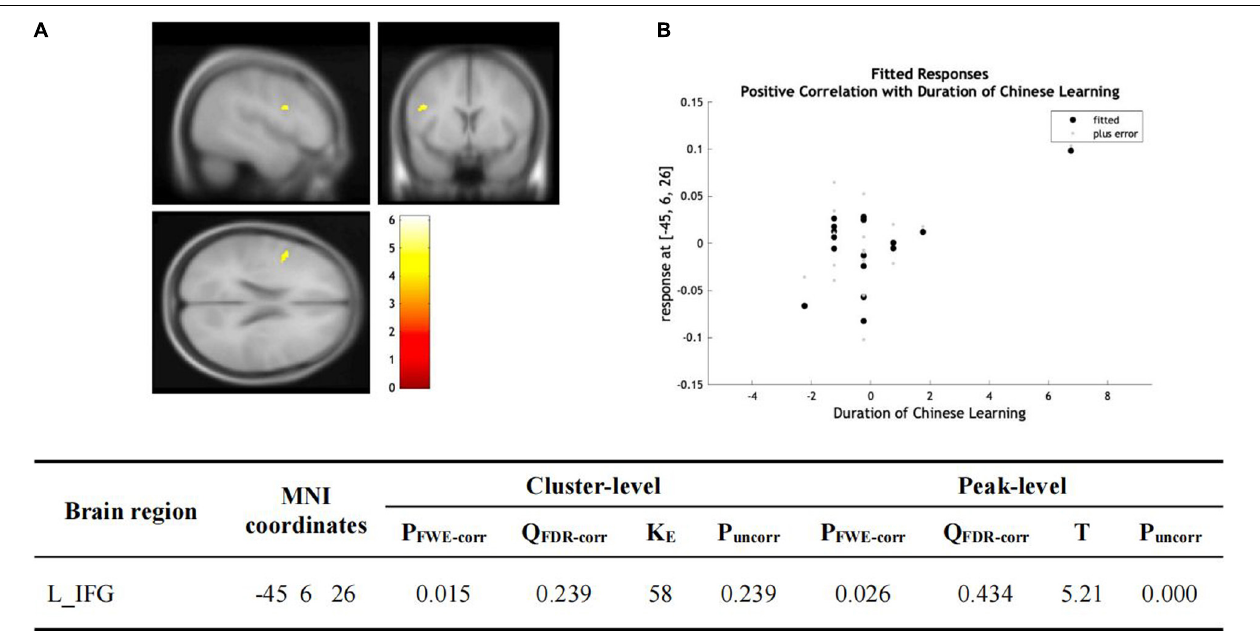
FIGURE 4 | (A) Statistical parametric maps (threshold at P < 0.001, uncorrected for display purpose showing the results from the regression analysis of Chinese learning time on gray matter volume using VBM). Sex, ages, AoA-L2, the number of languages learned, Raven’s performance were considered as the covariates and then were regressed out in the statistical analysis. Increased gray matter volume in left IFG was associated with longer Chinese learning time for the subjects who had learned Chinese. This result was significant after correction for multiple comparisons using small volume corrections ( P < 0.05). (B) GMV in the cluster centered at (–45, –6, –26) correlates with the reading accuracy of Chinese characters in the left